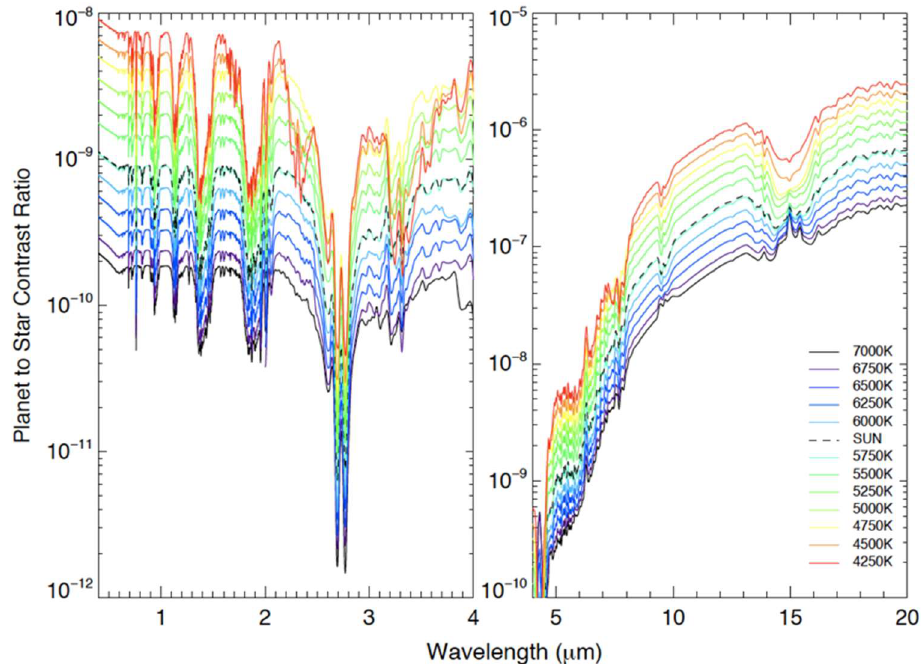
Figure 4. The F p / F * ratios for an Earth-analogue cloud coverage orbiting a cool star. The planet is assumed to receive the same energy per unit surface as the Earth receives from the Sun (the wavelength integrated stellar flux received on top of the planet’s atmosphere is 1370 Wm − 2 ) (from [3]).